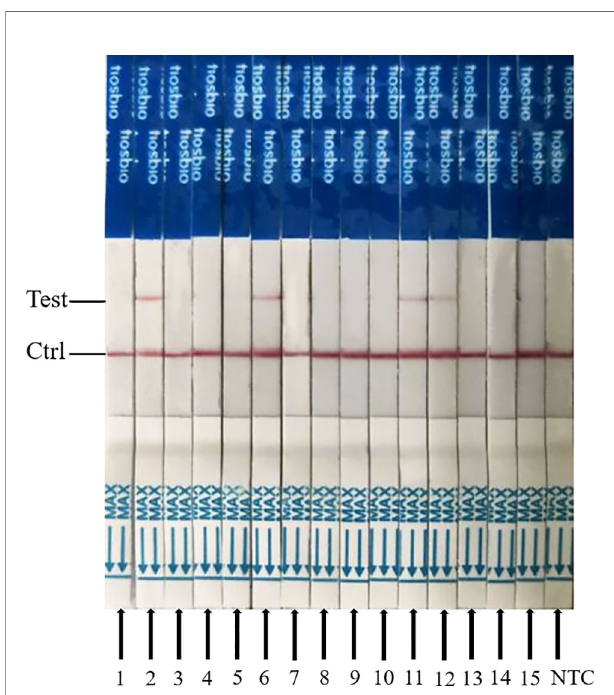
FIGURE 8 | Clinical sample results of ERA-CRISPR/Cas12a combined with ERA analysis. 1 – 15 indicate different clinical samples; NTC, negative control of RNase-free ddH 2